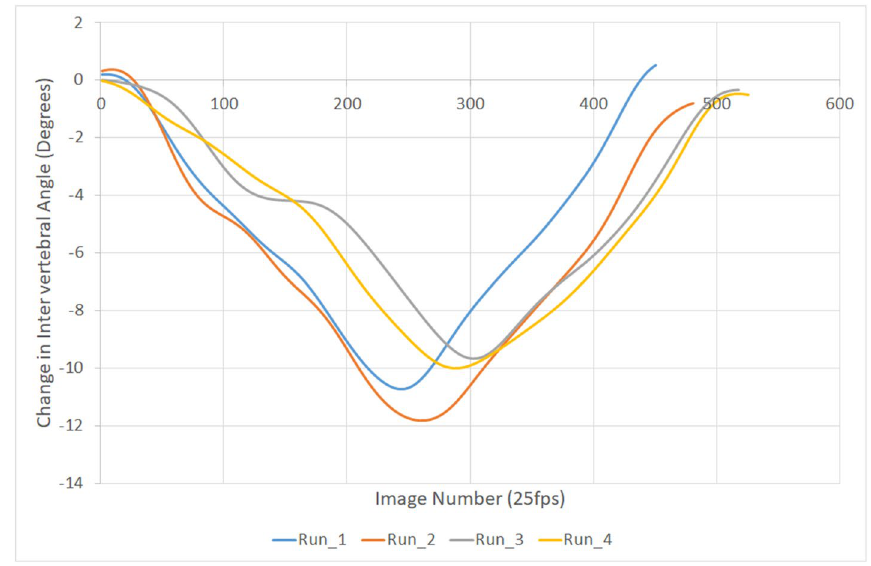
Figure 1. Example of repeated motion paths over time at C3–C4 for one participant.